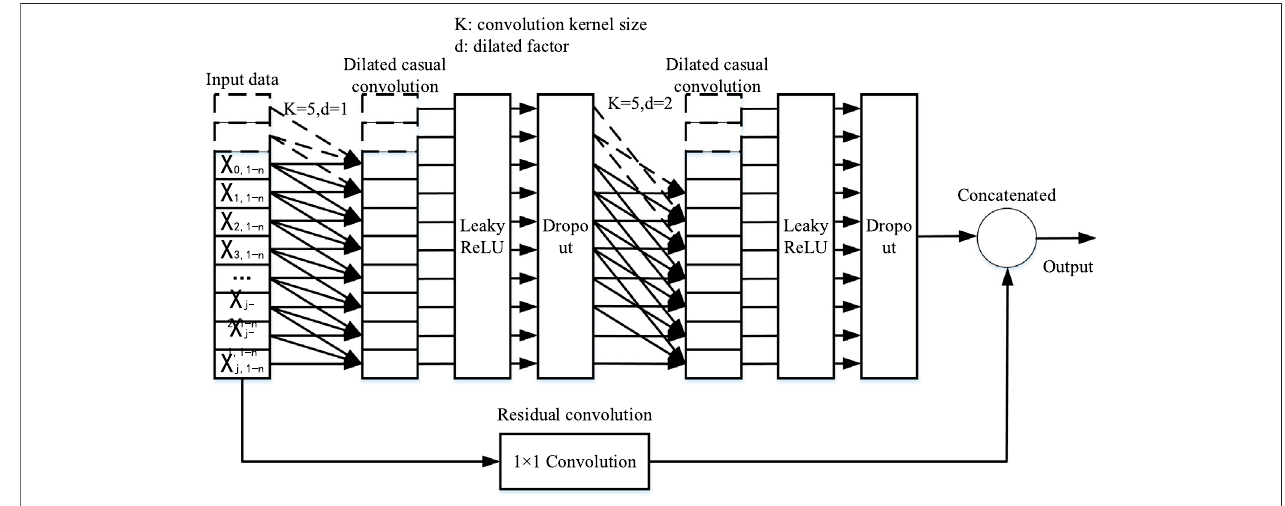
FIGURE 1 | Flowchart of TCN residual convolution.